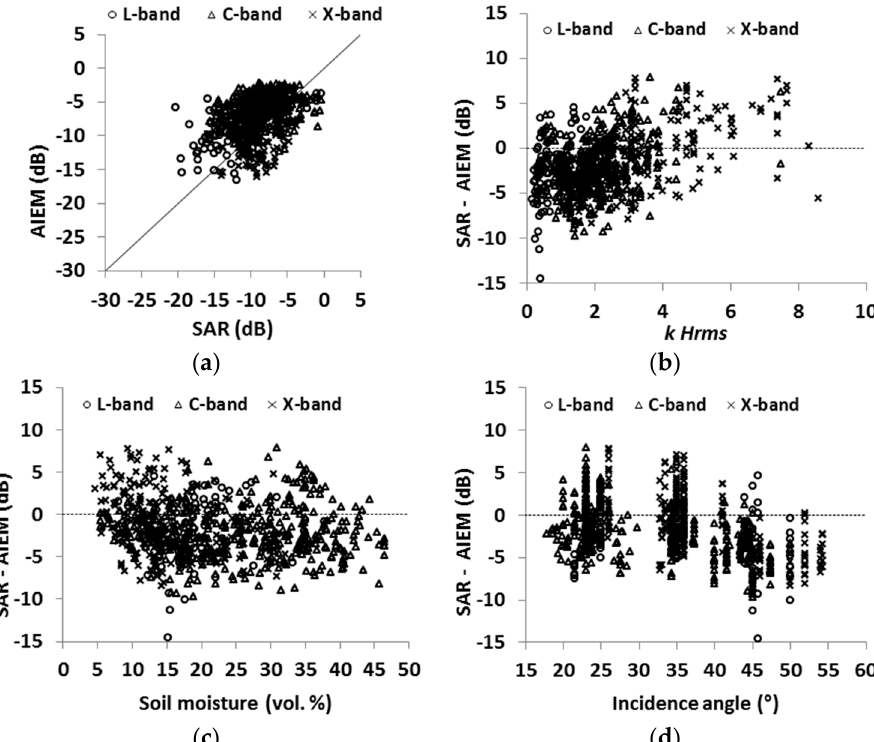
Figure 18. Comparison between radar backscattering coefficients calculated from SAR images and those estimated from AIEM for VV polarization using ECF. ( a ) AIEM simulations vs. SAR data; ( b ) difference between SAR signal and AIEM vs. soil roughness ( kHrms ); ( c ) difference between SAR signal and AIEM vs. soil moisture ( mv ); ( d ) difference between SAR signal and AIEM vs. incidence angle.